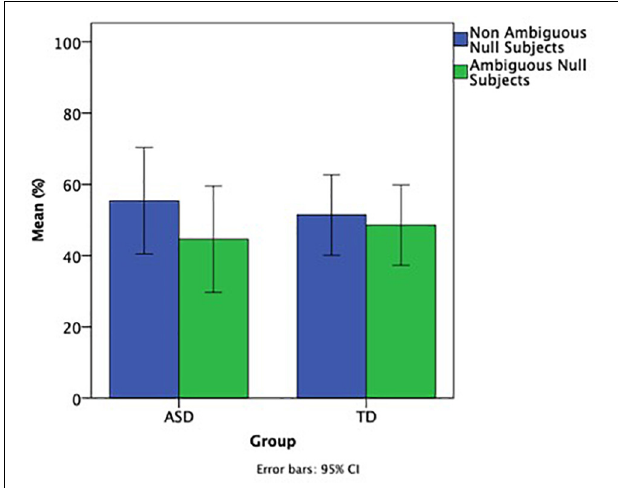
FIGURE 2 | Ratio of ambiguous and non-ambiguous null subject pronouns. FIGURE 3 | Ratio of strong and clitic object pronouns as well as object DPs.